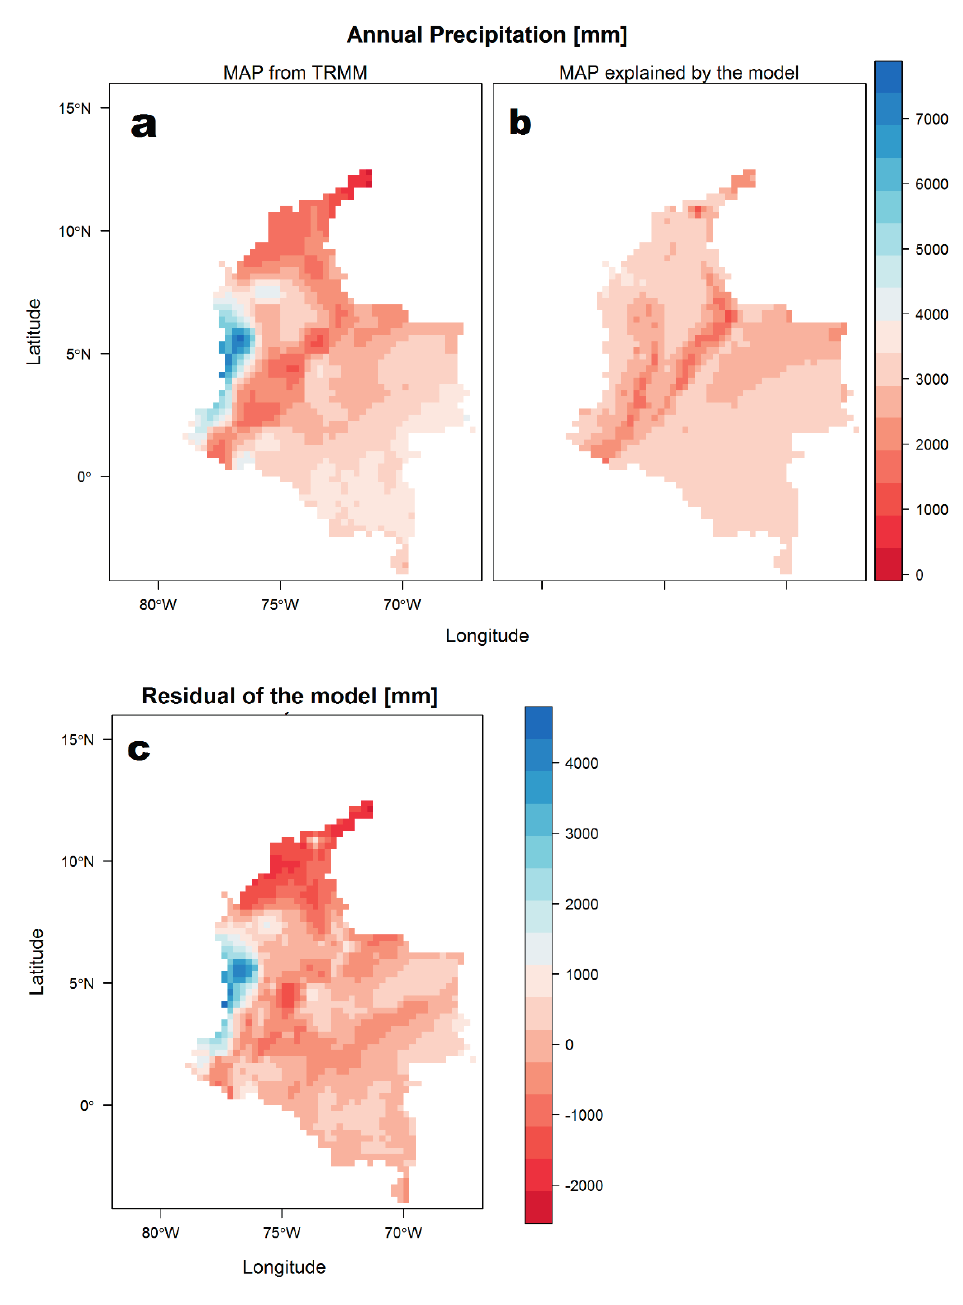
Figure 2. Example of Global regression of annual precipitation for Colombia, where we assume that the relationship among Mean Annual Precipitation ( MAP ), Digital Elevation Model ( DEM ) and Enhanced Vegetation Index ( EVI ) is spatially homogeneous. ( a ) represents the MAP from Tropical Rainfall Measuring Mission ( TRMM ), ( b ) represents the MAP explained by a global model of DEM and EVI , ( c ) shows the residual of the model. Note that (a) and (c) exhibit the same spatial